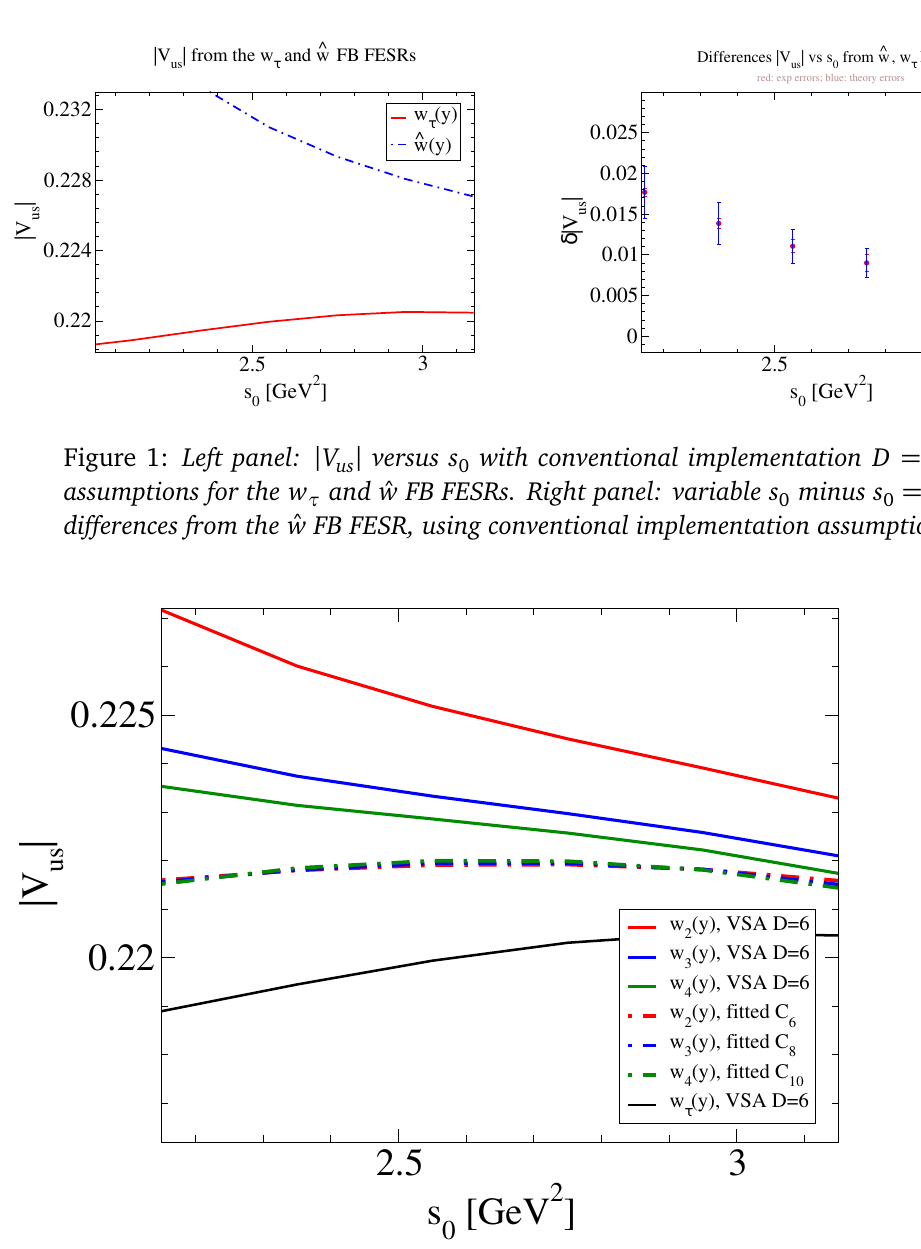
dependence of 0 , w 2 3 , C and C obtained 6 8 10